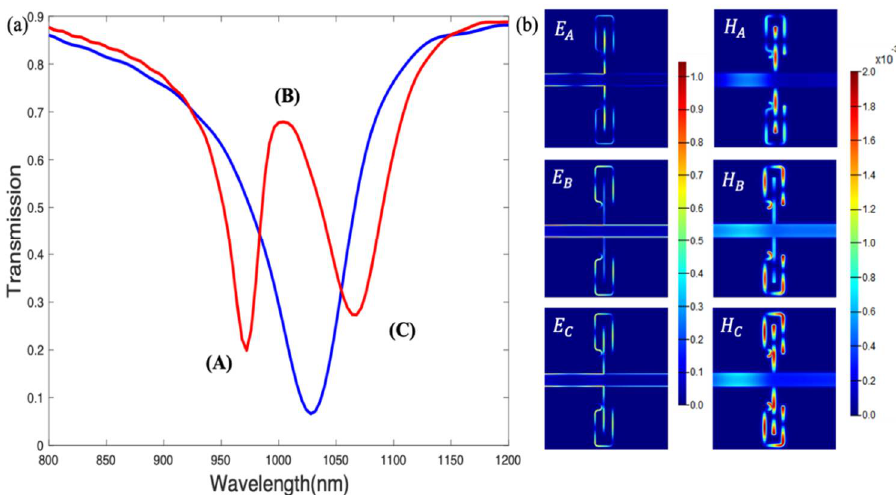
Figure 2. ( a ) System transmission spectra with or without U-like resonator. ( b ) Distributions of electric amplitude and magnetic amplitude corresponding to the frequency values represented by f A , f B and f C , in ( a ).